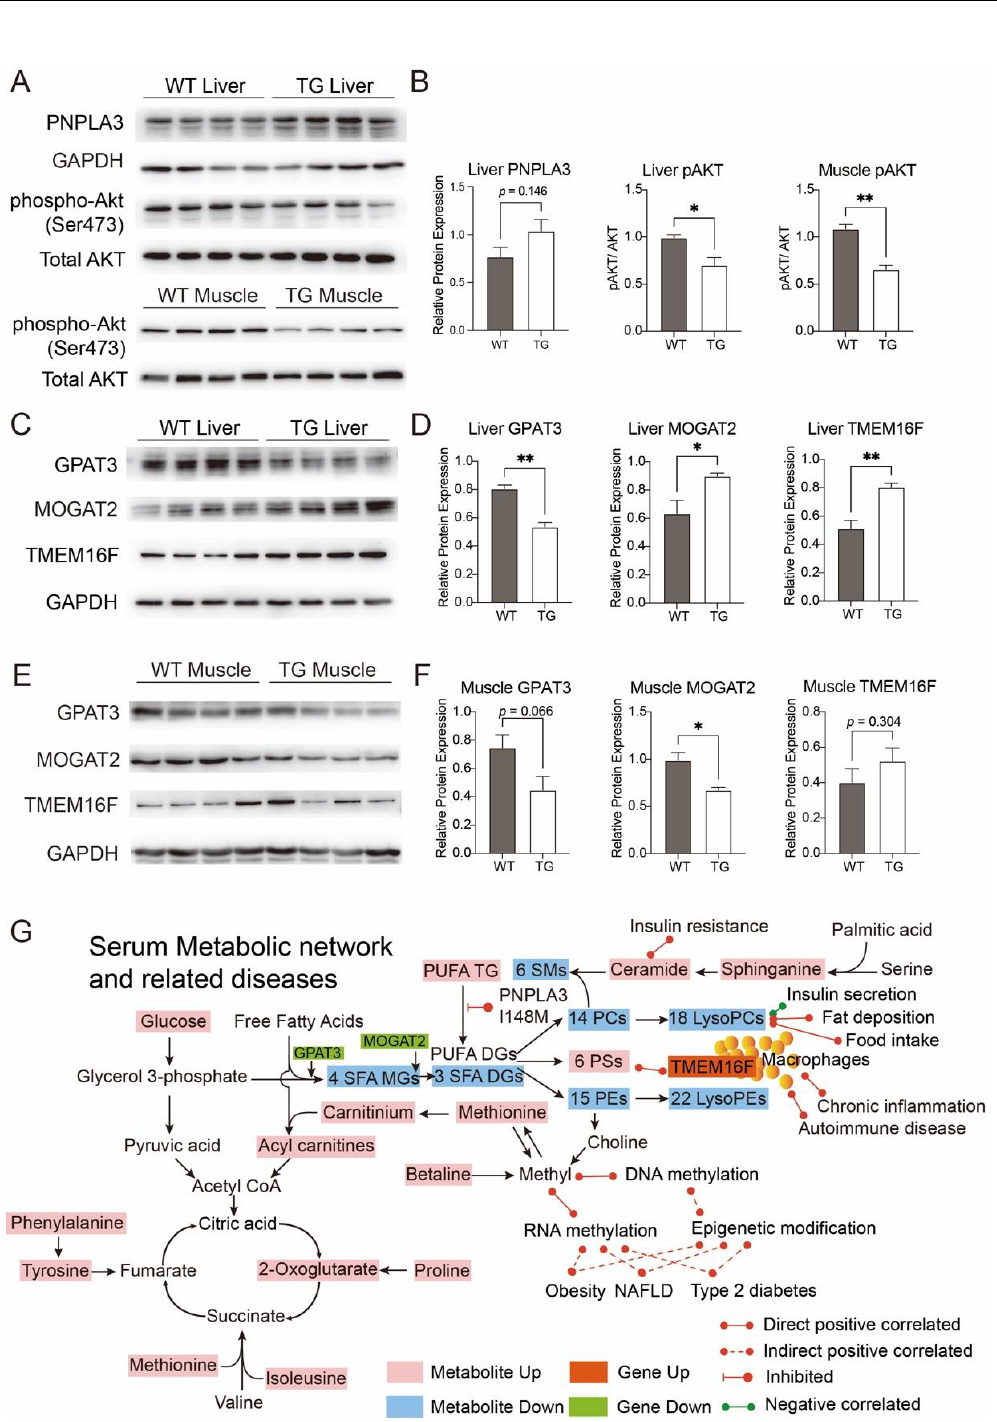
Figure 4. Immunoblotting results and the metabolic network of differential metabolites between PIGinH11 (TG) and wild-type (WT) pigs after 2-months of HFHSD. ( A , B ) Protein expression of total PNPLA3 (porcine PNPLA3 and humanized PNPLA3 I148M ) was detected using liver samples. The degree of Akt activation was investigated by detecting phosphor-Akt. The lower ratio of phosphorylated Akt Ser473 to total Akt in TG samples indicated suppressed Akt signaling. The protein expressions of GPAT3, MOGAT2, and TMEM16F were detected using liver ( C , D ) and skeletal muscles ( E , F ) from TG and WT pigs. The differential metabolites’ network was shown in ( G ). GPAT3, Glycerol-3-Phosphate Acyltransferase 3, also refers as MAG1. MOGAT2, Monoacylglycerol O-Acyltransferase 2. TMEM16F, anoctamin 6, also refers as ANO6. Data were shown as mean ±SD, n = 4 per group, * p < 0.05, ** p < 0.01.